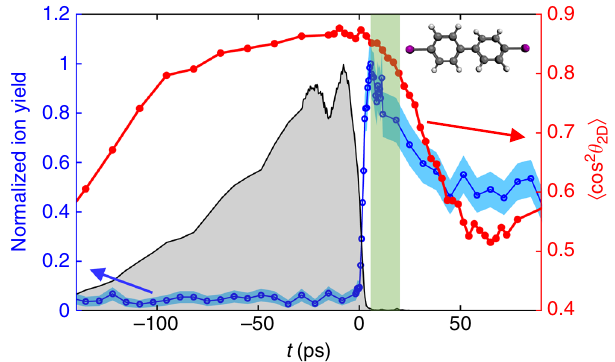
Fig. 3 Time-dependent yield of intact diiodobiphenyl + ions from strong- fi eld ionization. The DIBP molecules are 1D aligned. The 800 nm ionization pulse is 40 fs long (full-width at half-maximum (FWHM)), has an intensity of 2.4 × 10 14 W cm − 2 and is linearly polarized perpendicular to the polarization axis of the alignment pulse. The blue shaded area represents the 95% con fi dence intervals for the parent signal, assuming Poisson statistics. The time-dependent degree of alignment is shown by the red curve